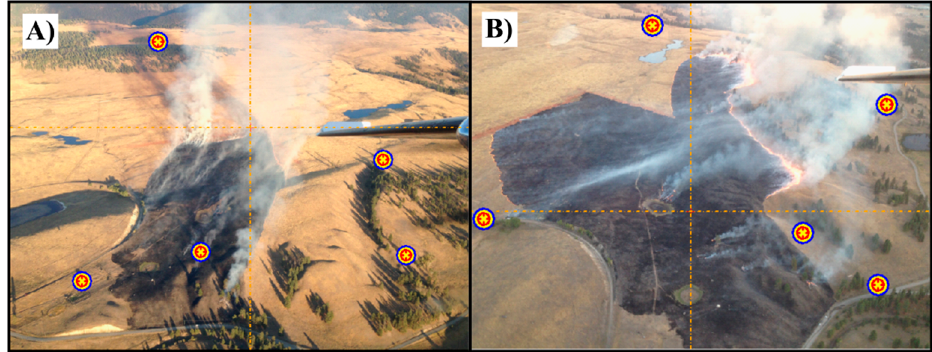
Figure 5. Overlapping user defined (yellow X’s), MPT computed GCPs (blue circles) and computed image centre (dotted line crosshairs) displaying successfully calibrated wildfire images for Site 3: image 3A ( A ) and 3B ( B ).